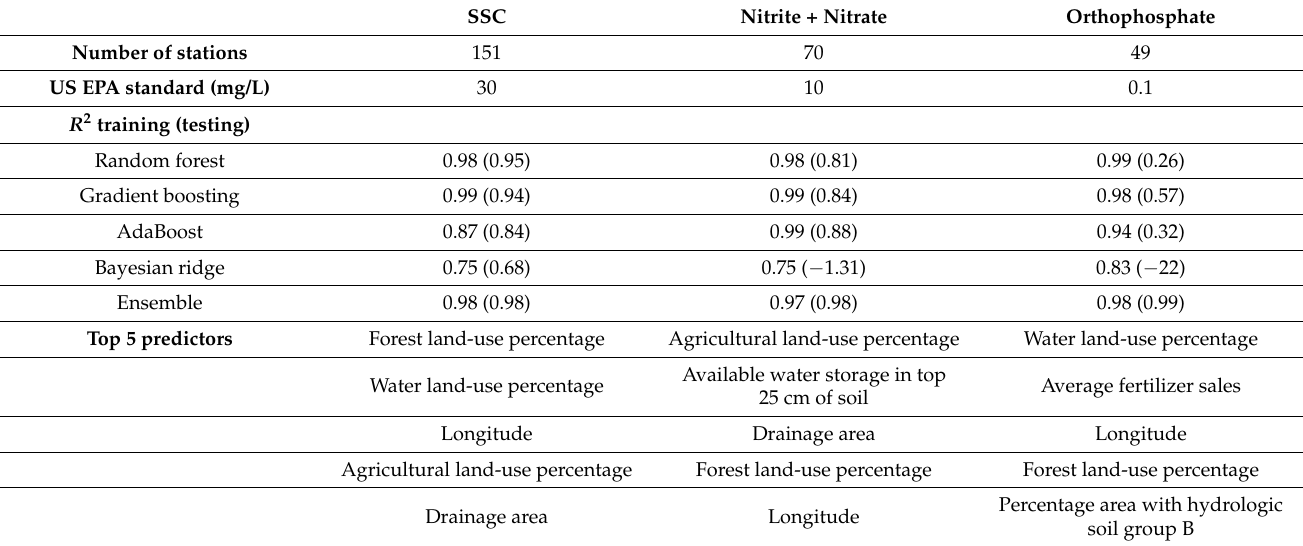
Table 1. Goodness of fit measures of ML models and top five predictors of watershed health. The coefficient of determination R 2 for the training set is the average value obtained during 5-fold cross validation, while the value given between the parentheses is the R 2 value for the test set. SSC Nitrite +